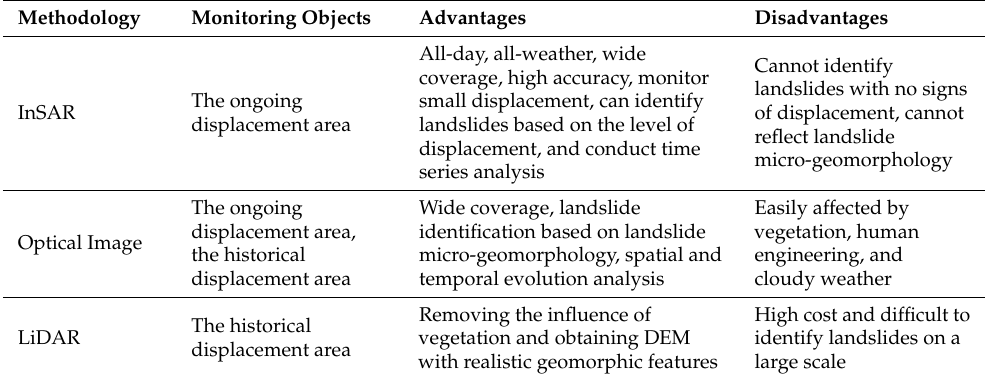
Table 2. Advantages and disadvantages of the three remote sensing techniques and monitoring